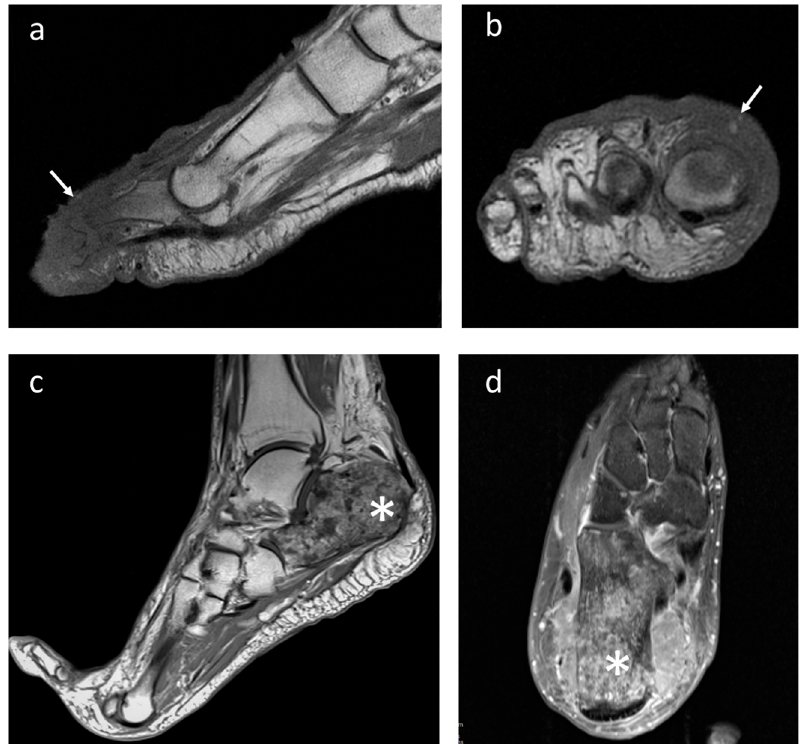
Figure 3. Right forefoot metastasis in a female patient with anaplastic large cell lymphoma (white arrows). Imaging appearance at MRI in ( a ) sagittal and ( b ) coronal projection; ( c ) metastasis from melanoma showing a full necrotic appearance of the calcaneus (asterisk) on T1-weighted sagittal and ( d ) transverse T2-weighted sequences.